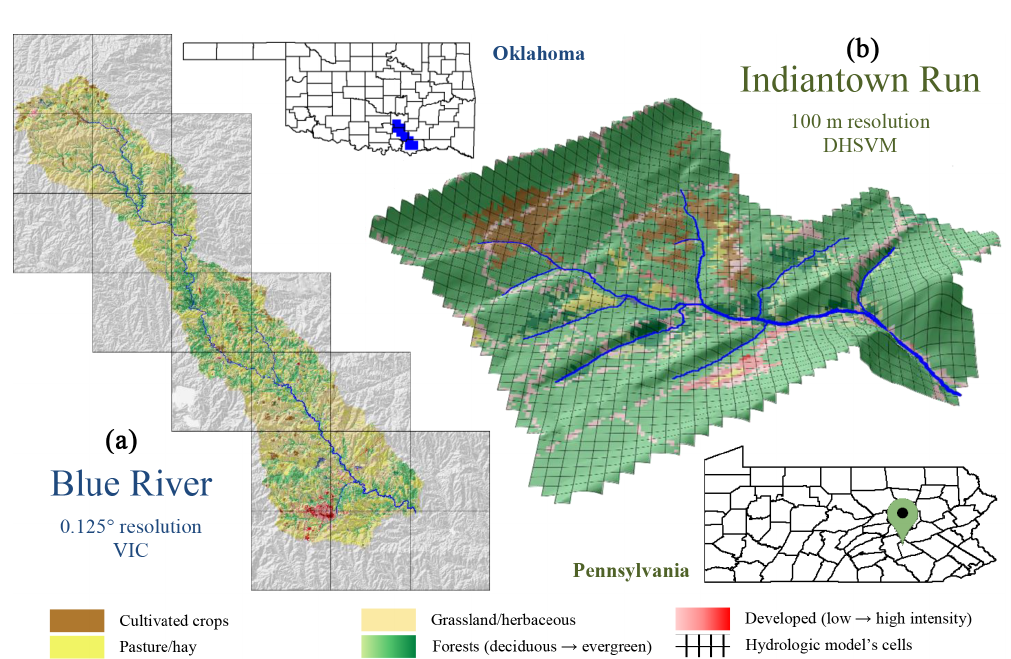
Figure 2. Maps of the two test watersheds in the United States displaying the 30m resolution land cover distribution from the NLCD (Homer et al., 2012). (a) Oklahoma’s Blue River watershed 0.125 ◦ resolution VIC model application (20 cells). (b) Pennsylvania’s Indiantown Run watershed 100m resolution DHSVM model application (1472